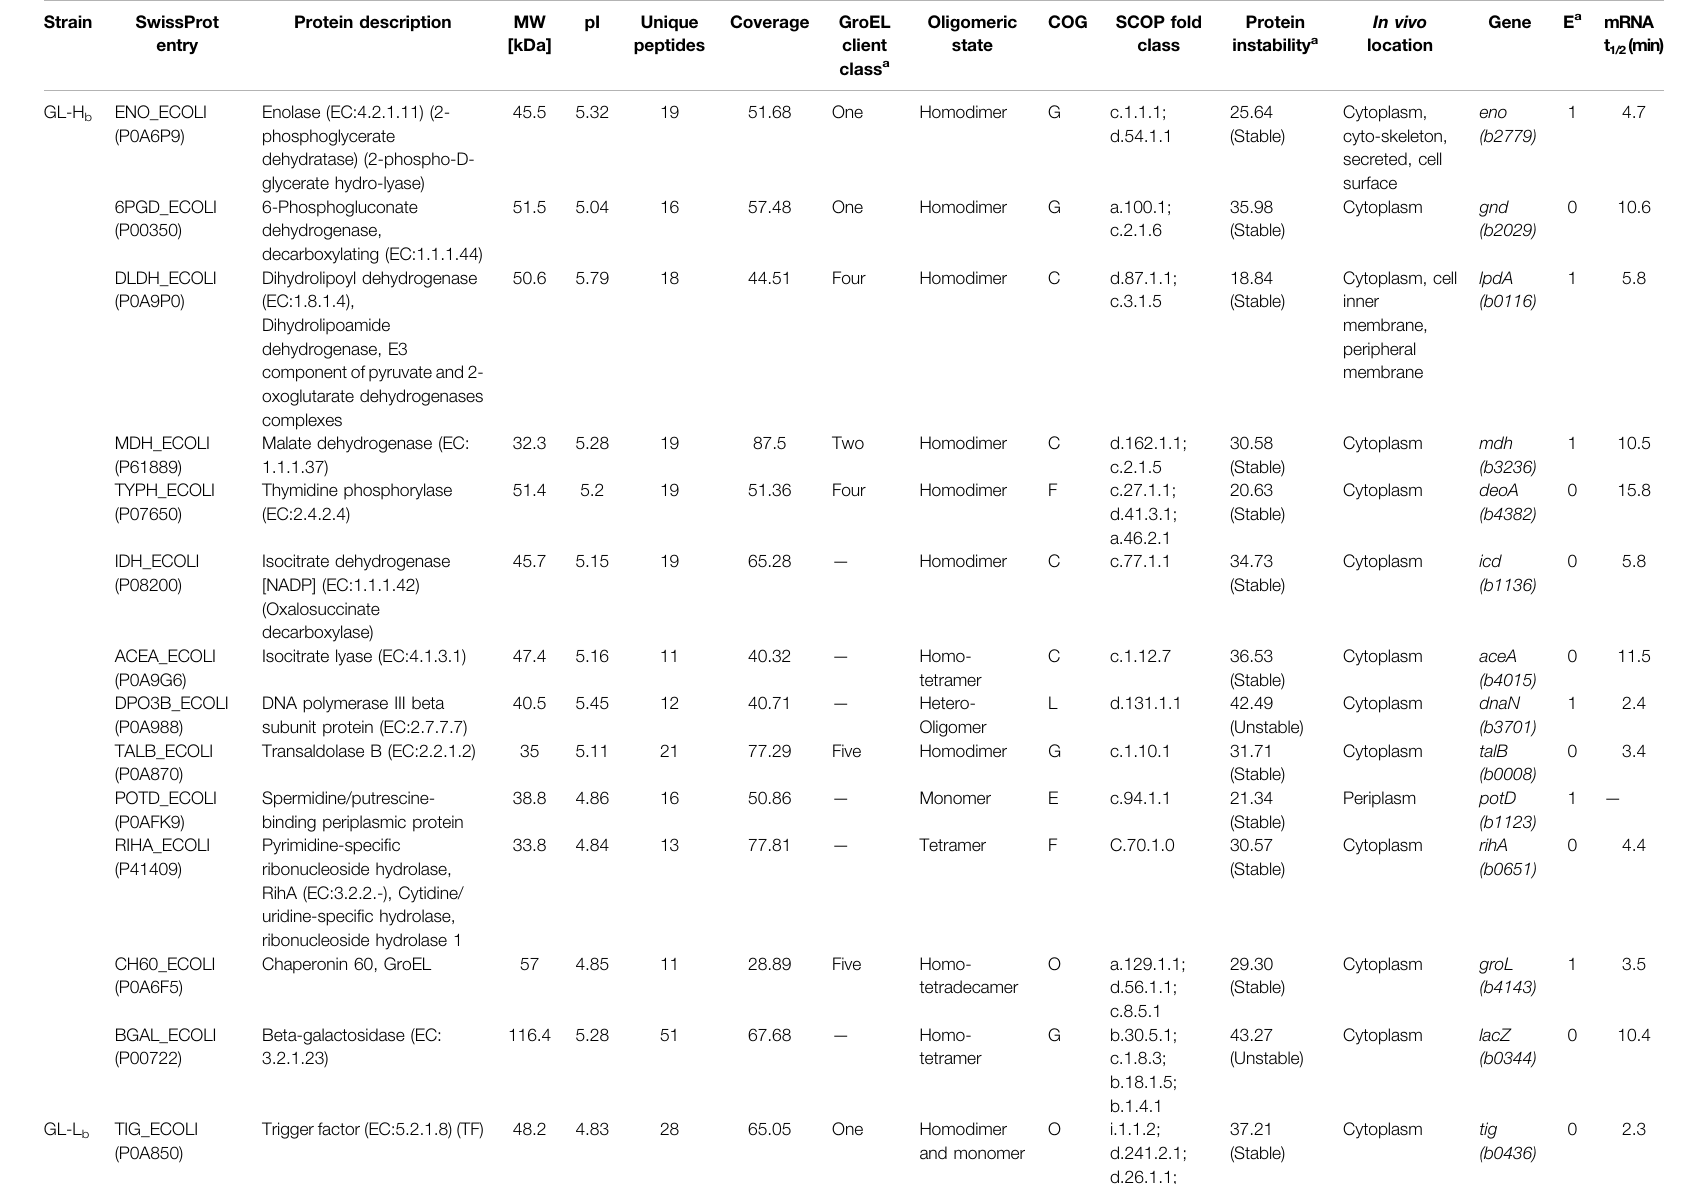
TABLE 1 | Properties of the differentially enriched proteins in GL-H b and GL-L b strains. Strain SwissProt